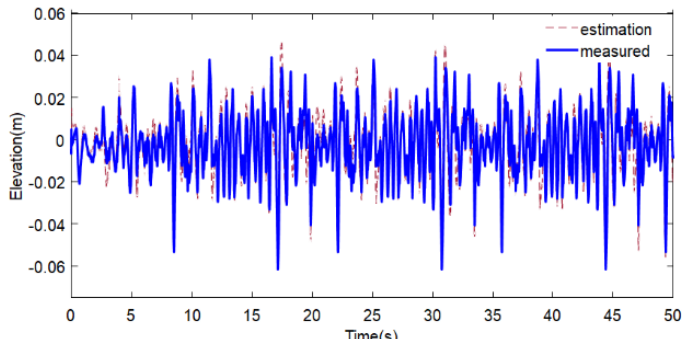
Figure 7. Simulation result of unknown road roughness input; ( a ) estimation of road roughness input, ( b ) estimation error between measured and estimated road roughness.